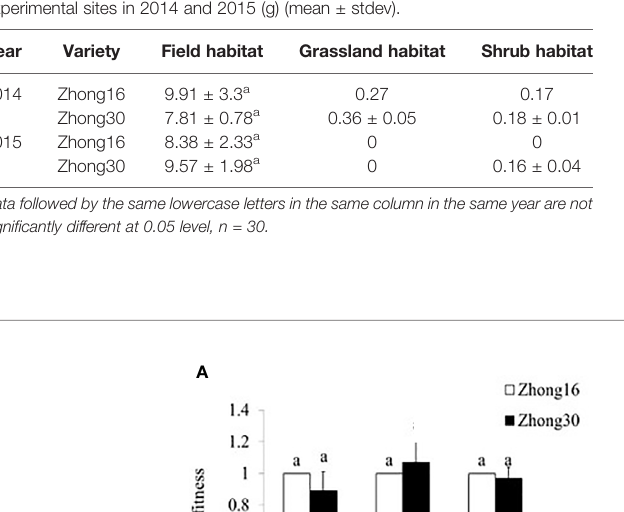
TABLE 4 | Production of seeds per plant of different cotton varieties at different experimental sites in 2014 and 2015 (g) (mean ± stdev).